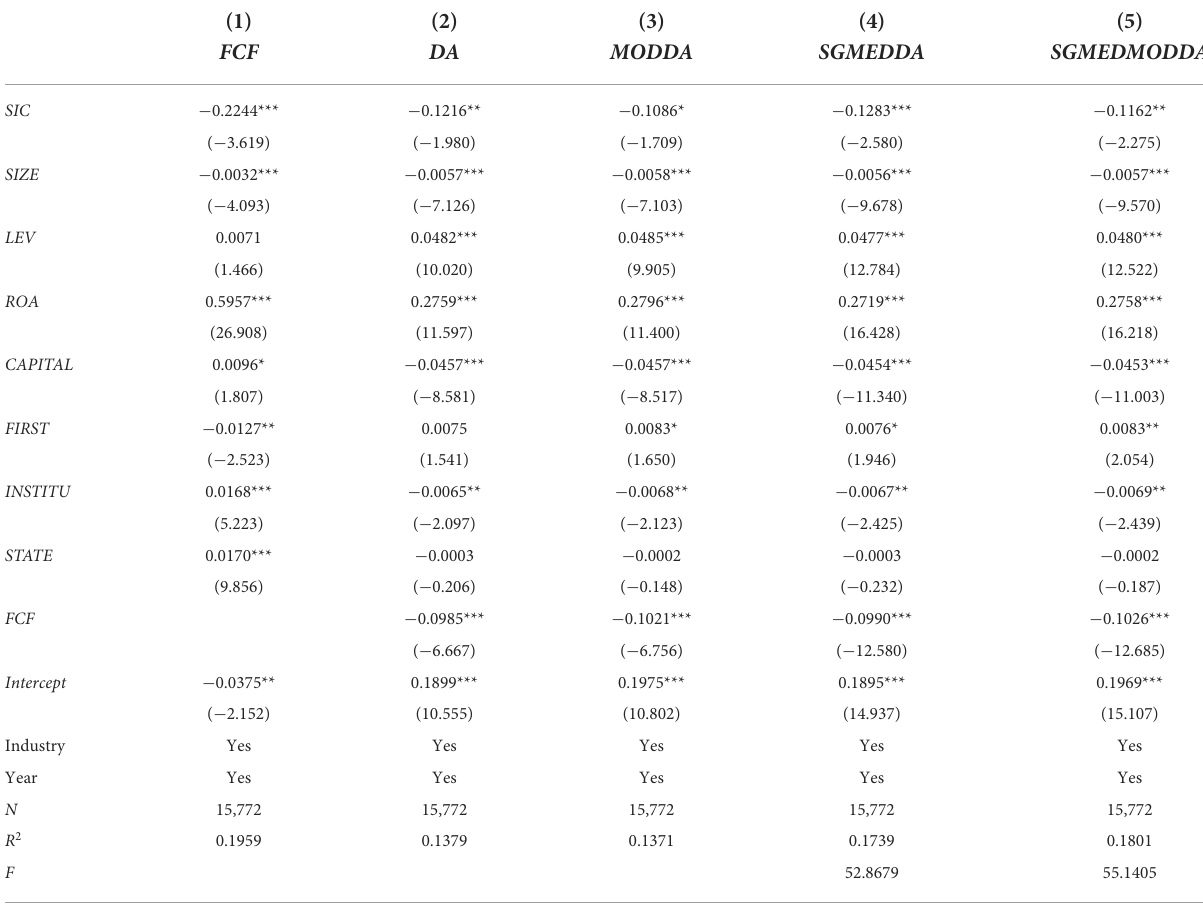
TABLE 4 Social insurance payment burden, free cash flow level, and earnings management—mediation